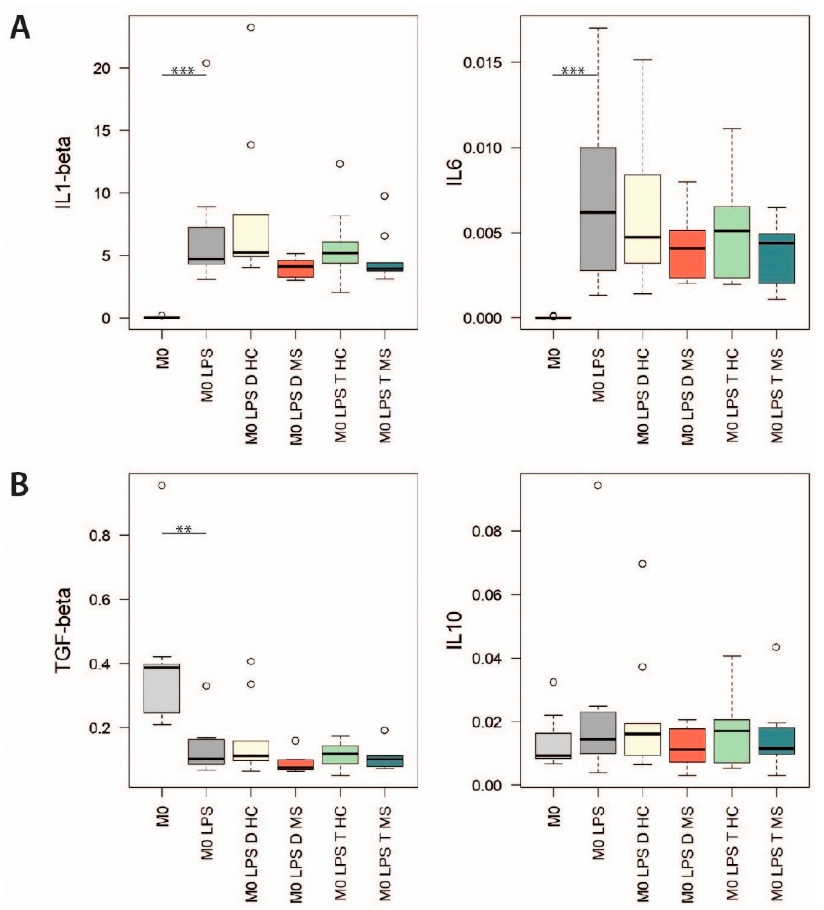
Figure 4. Gene expression analysis on activated CD14 + monocytes conditioned with EVs. Relative expression (2 − ∆ Ct ) of ( A ) the proinflammatory cytokines IL1- β and IL-6 and ( B ) the anti-inflammatory cytokines TGF- β and IL-10. Kruskal–Wallis with Dunn’s post hoc test, ** 0.001 ≤ p < 0.01; *** p < 0.001.